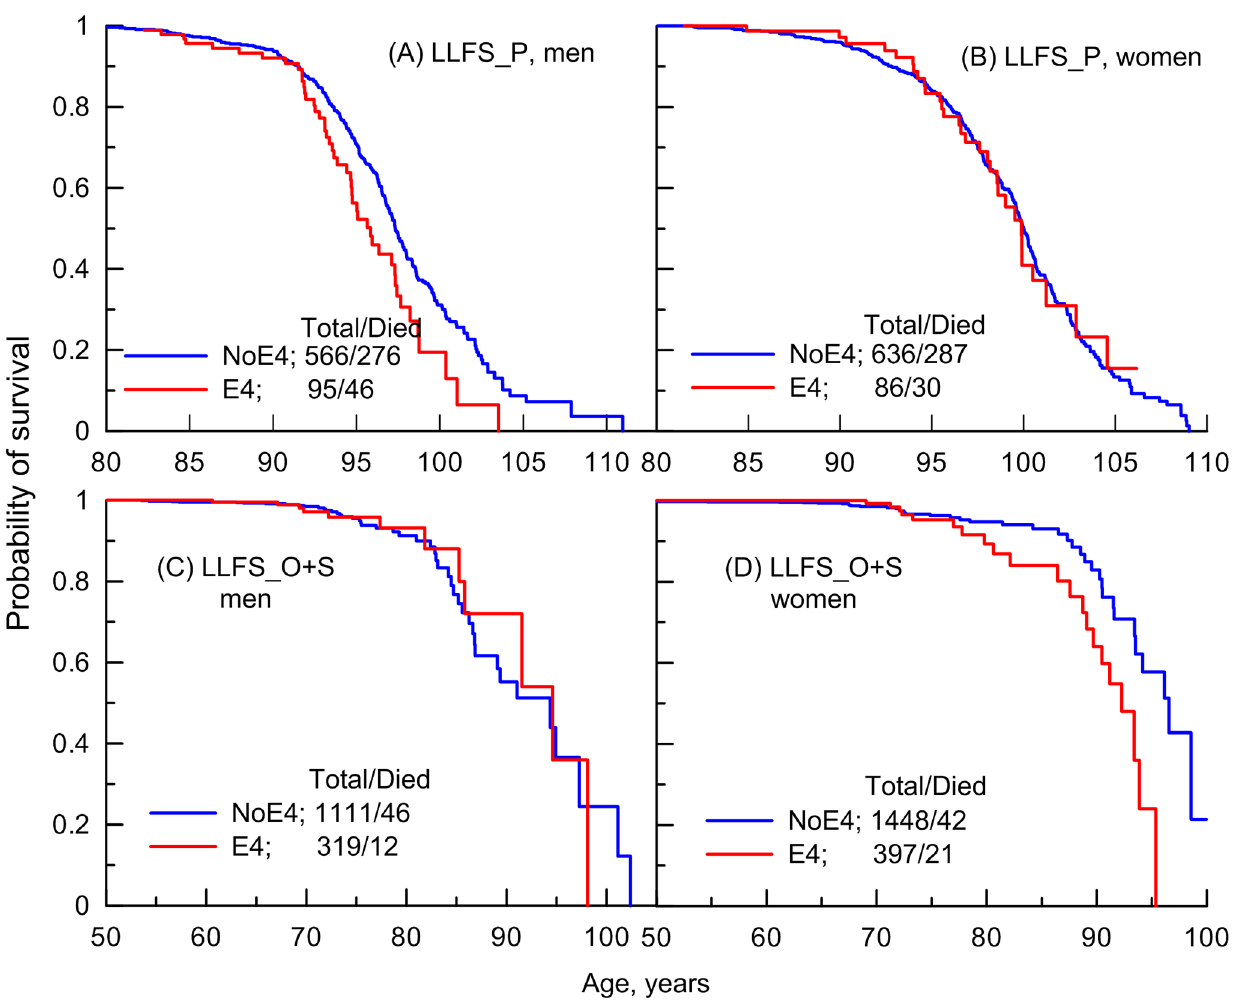
Figure 2. Empirical age patterns of survival of the ApoE4 carriers and non-carriers in the LLFS. Patterns are shown for (A and C) men, (B and D) women; and for (A and B) long-living individuals (LLFS_P) and (C and D) offspring of long-living individuals and spouses (LLFS_O + S) who carry (E4) and do not carry (NoE4) the ApoE4 allele. By design, the LLFS included long-living individuals who were aged 80 + years at entry. Offspring of long-living individuals and spouses were pooled together because of the small number of deaths among them (Table 1). The numbers in the insets show the total number of genotyped individuals and the number of deaths among them.